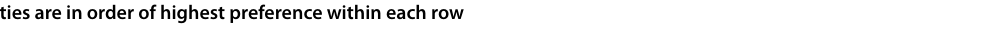
a Multiple distinct choices were possible